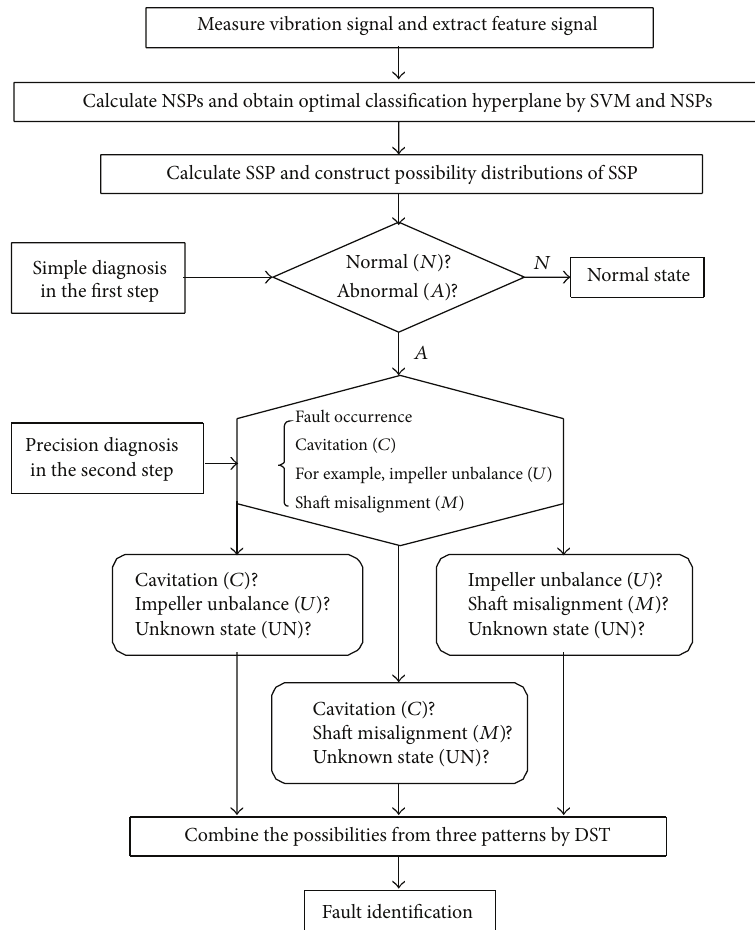
Figure 11: Flowchart of sequential diagnosis for a pump